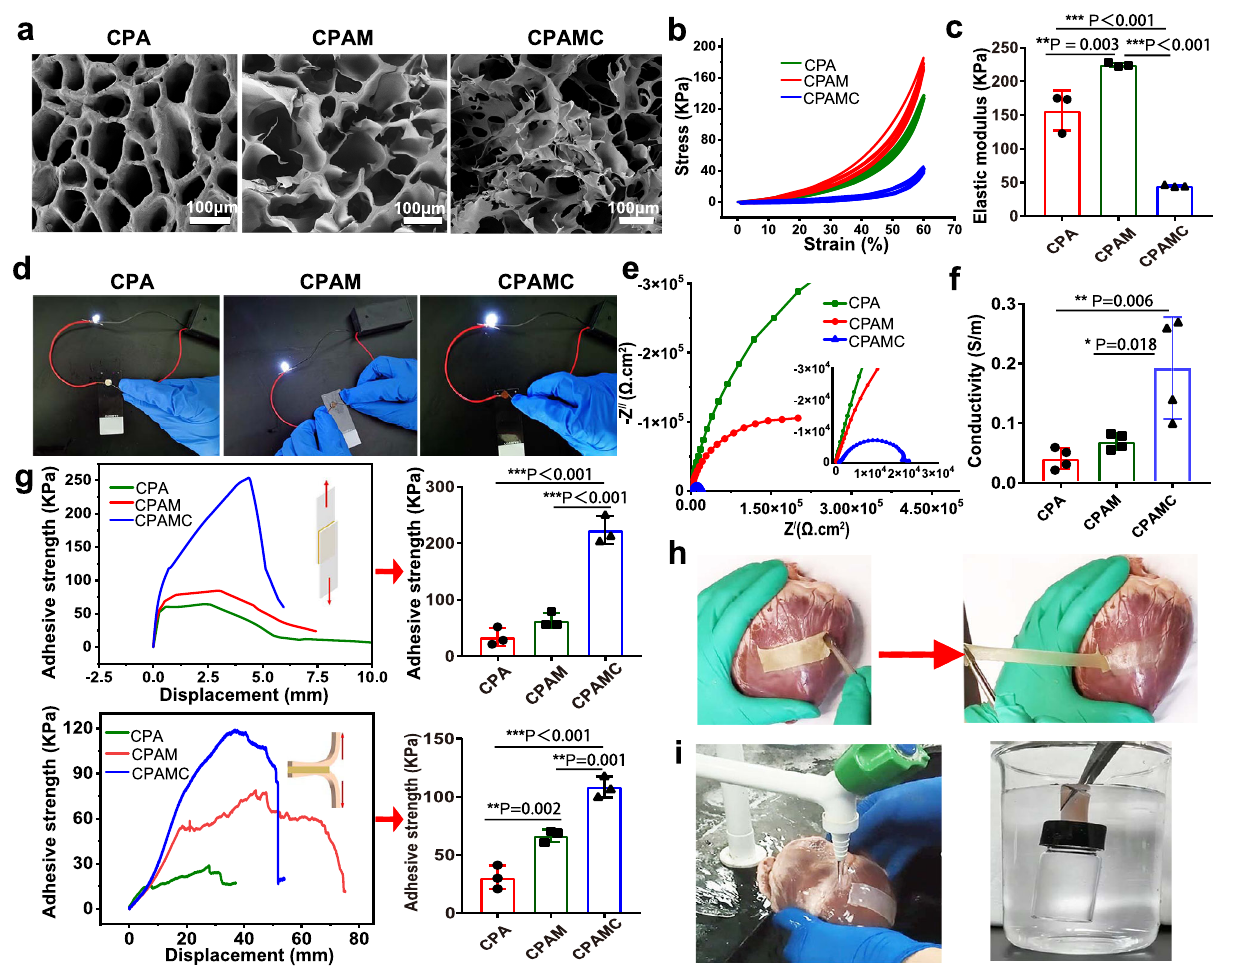
Fig. 2 | The morphological, conductive, and mechanical characteristics of the adhesionhydrogels.a SEMimagesofCPAhydrogel,CPAMhydrogel,andCPAMC hydrogel, scale bars: 100 μ m. b The stress – strain curves of CPA hydrogel, CPAM hydrogel, and CPAMC hydrogel. c The elastic modulus of CPA hydrogel, CPAM hydrogel,andCPAMChydrogel(errorbarmeansthestandarddeviation,* p <0.05, ** p <0.01, *** p <0.001, p value was generated by one ‐ way analysis of variance (ANOVA), followed by Tukey ’ s multiple ‐ comparison post hoc test, n =3 indepen- dent samples). d The luminance changes of the LED light bulb in CPA hydrogel, CPAM hydrogel, and CPAMC hydrogel. e Nyquist plots of CPA hydrogel, CPAM hydrogel, and CPAMC hydrogel. f Statistical analysis of conductivity in CPA hydrogel, CPAM hydrogel, and CPAMC hydrogel (error bar means the standard deviation, * p <0.05, ** p <0.01, *** p <0.001, p value was generated by one ‐ way